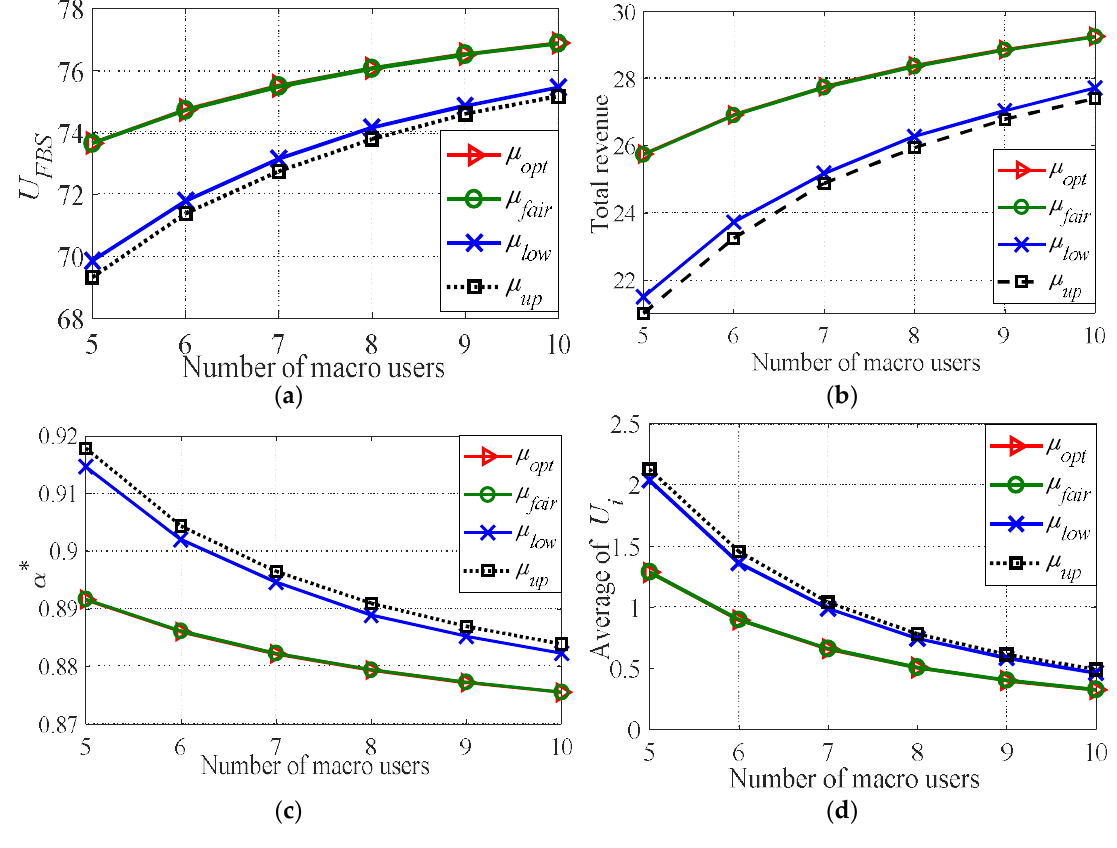
Figure 2 . Impact of increasing the number of macro users on system performance with (cid:1852) (cid:3036) = 1 . ( a ) Figure 2. Impact of increasing the number of macro users on system performance with Z i = 1. ( a ) Satisfied factor of femto user ( (cid:2009) ∗ ); ( b ) Utility of FBS; ( c ) Average utility of macro users; ( d ) Total Satisfied factor of femto user ( α ∗ ); ( b ) Utility of FBS; ( c ) Average utility of macro users; ( d ) Total revenue revenue of FBS. of